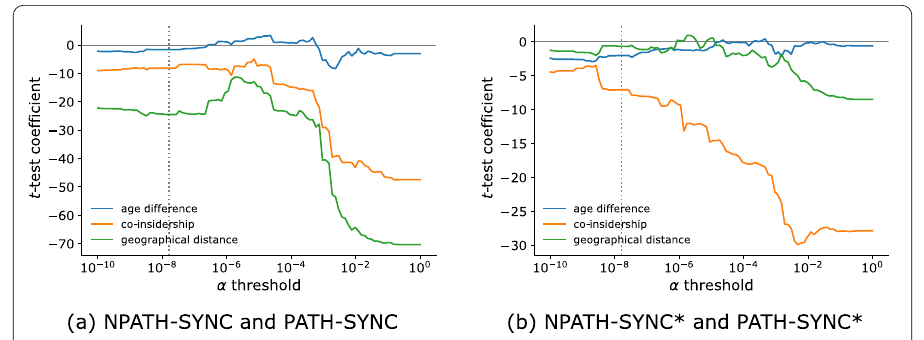
Figure 6 Welch’s t -statistic on the difference in age, length of co-insidership and geographical distance between (a) NPATH-SYNC (Eq. (14)) and PATH-SYNC (Eq. (13)) sets, and (b) NPATH-SYNC ∗ (Eq. (16)) and PATH-SYNC ∗ (Eq. (15)) sets. The statistic is reported for 100 log-spaced α thresholds used for the validation